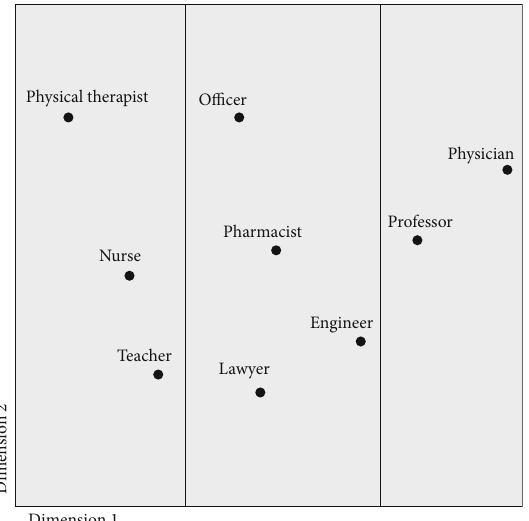
Figure 7: Euclidean model for overall occupational